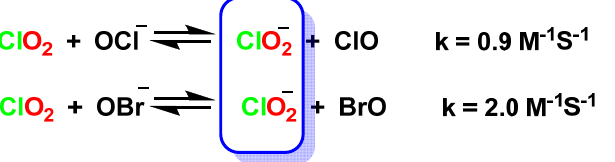
Figure 15. Effect of the OX − hypohalite ion on the disproportionation of ClO 2 in basic solution. In the second step, the reactions between ClO 2 and XO form XOClO 2 , Figure 16.